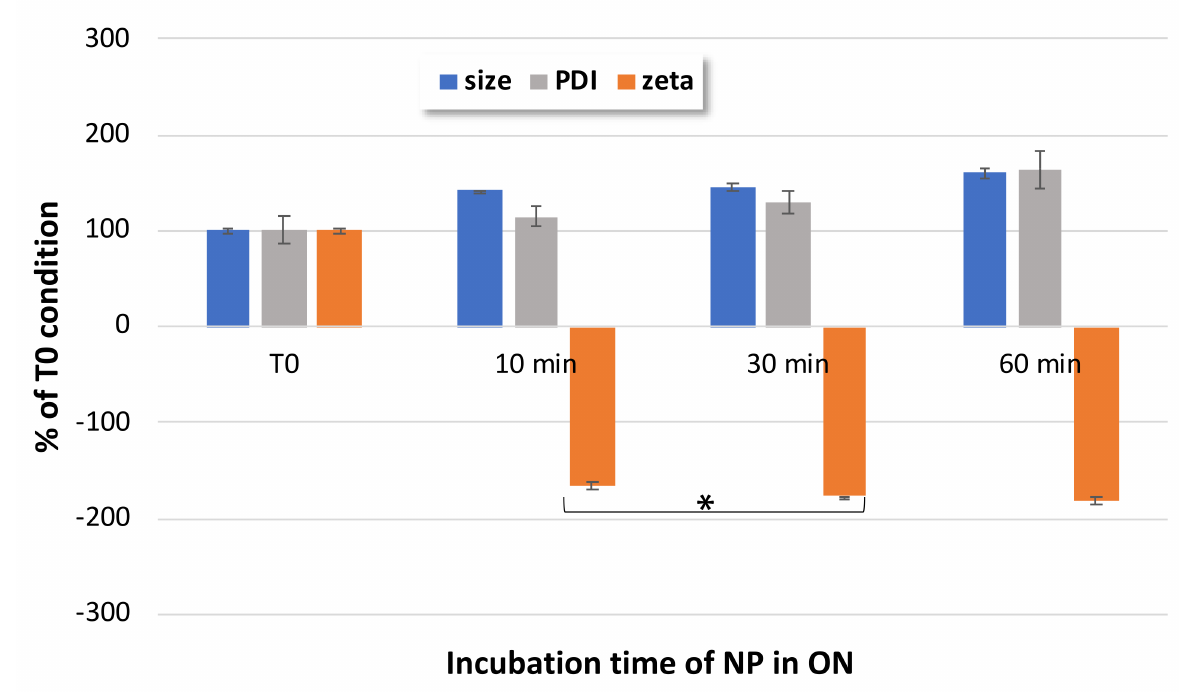
Figure 6. Impact of incubation time on ON α 600 NP size, PDI and zeta potential, as compared to non-incubated CFX–DOTAU NP (at T0 time); * Student t -test was considered significant for p < 0.05.